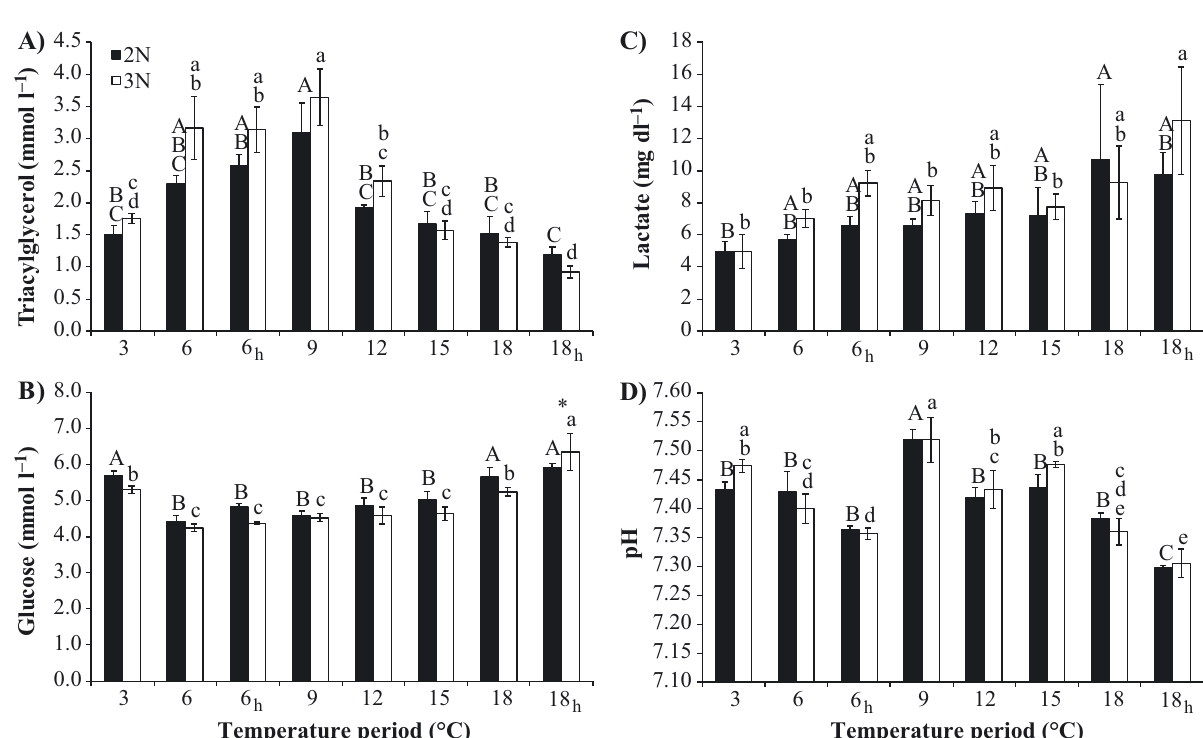
Fig. 7. Mean ± SE plasma (A) triacylglycerol, (B) glucose, (C) lactate and (D) pH levels in large diploid and triploid Atlantic salmon Salmo salar in seawater. See Fig. 2 for explanation of symbols